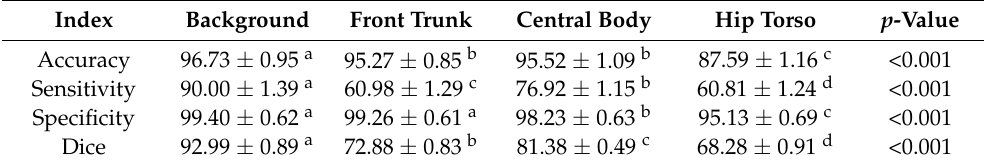
Table 3. Body-part detection performance parameters for side view of goats (%) *.